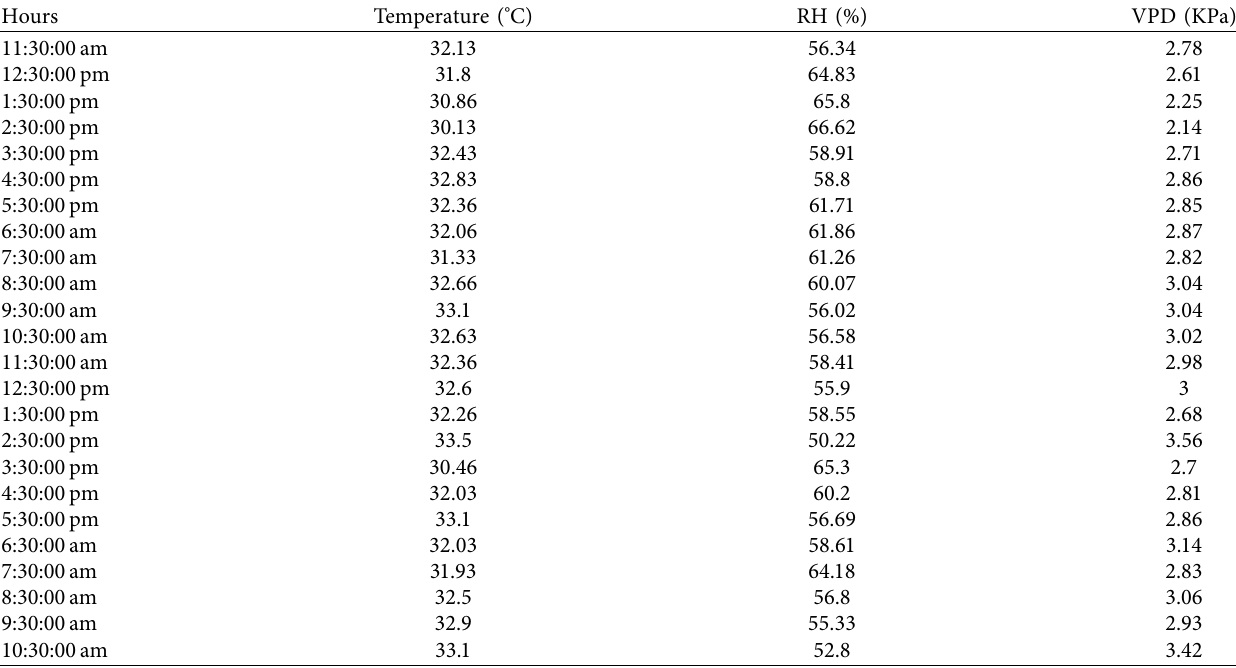
Table 2: Climatic condition and vapor pressure defcit (VPD) of the Lath House on 15 randomly selected days (average of 15 days). Hours